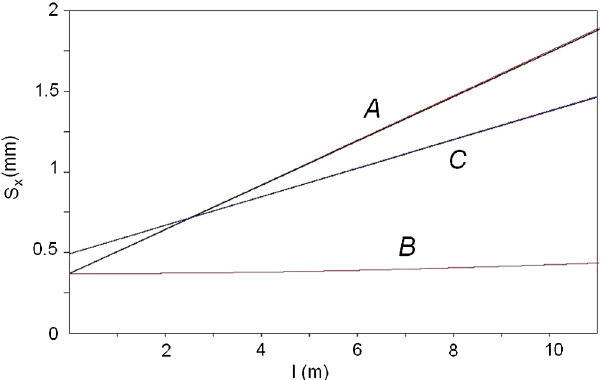
FIG. 10. Reconstructed beam envelope for a 180 GeV =c secondary beam (line A ) as a function of distance l from the Crystal 1, which was transformed into the defocusing one. The calculated uncertainty of the measured envelope function does not exceed 0.001 mm. Line B is the calculated beam envelope downstream of the standard strip crystal, and line C is the prediction of the beam envelope for a 400 GeV =c proton beam for the defocusing